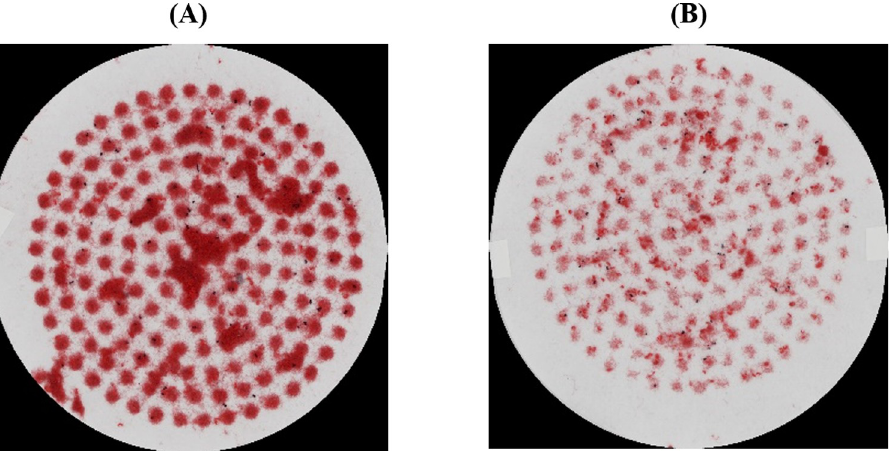
Fig 7. Comparison of filtered fibers collected from the dryer exhaust after the fourth cycle. Paper filter papers from the final Bu¨chner funnel filtration step used to collect fibers from the dryer exhaust of the fourth cycle, comparing the treatment without dryer sheet or anti-wrinkle fabric conditioner (A) with one involving one mega dryer sheet and double dose of anti-wrinkle fabric conditioner (B).